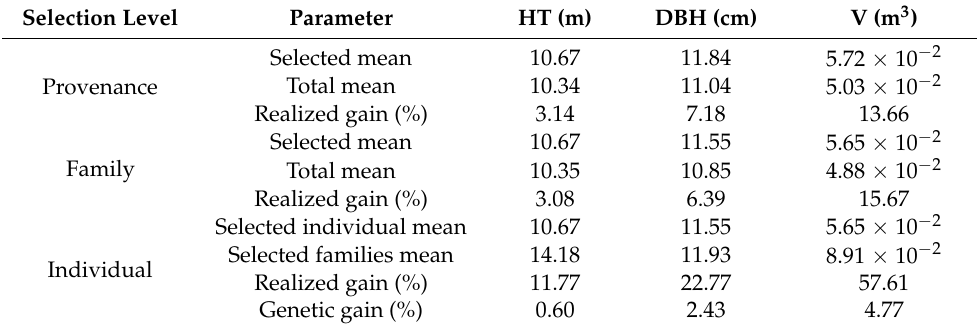
Table 6. Genetic gain of selection at different levels of